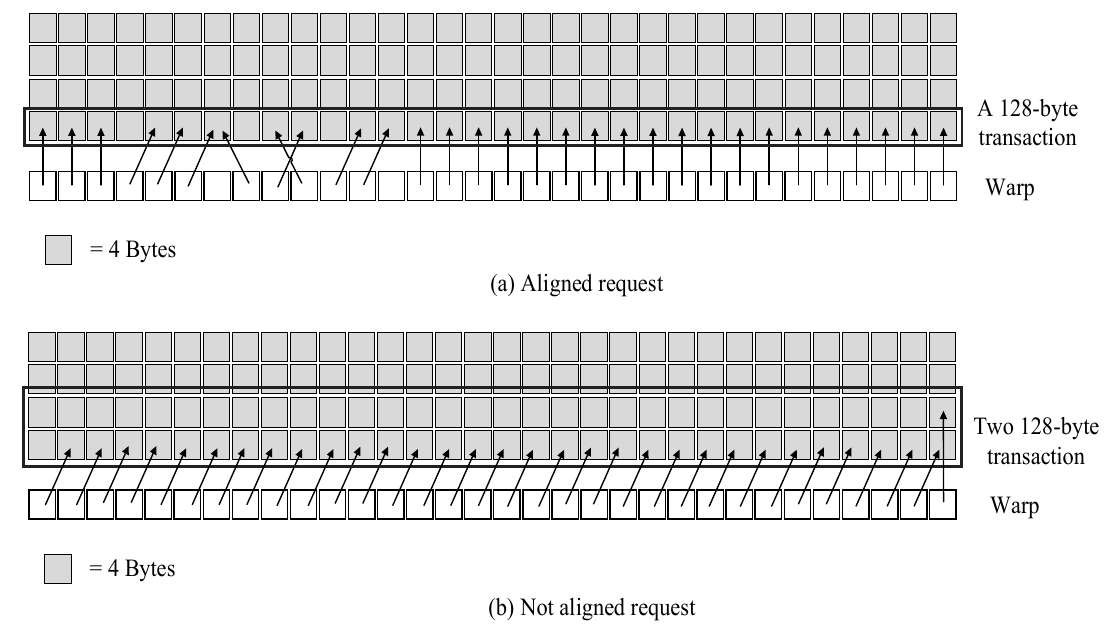
Figure 2. An example of baseline memory request coalescing.